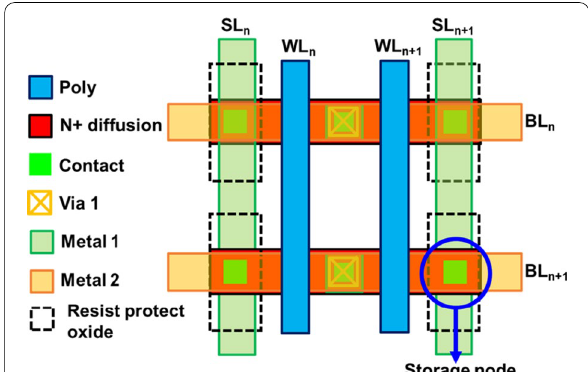
16 NOR type backfilled ×